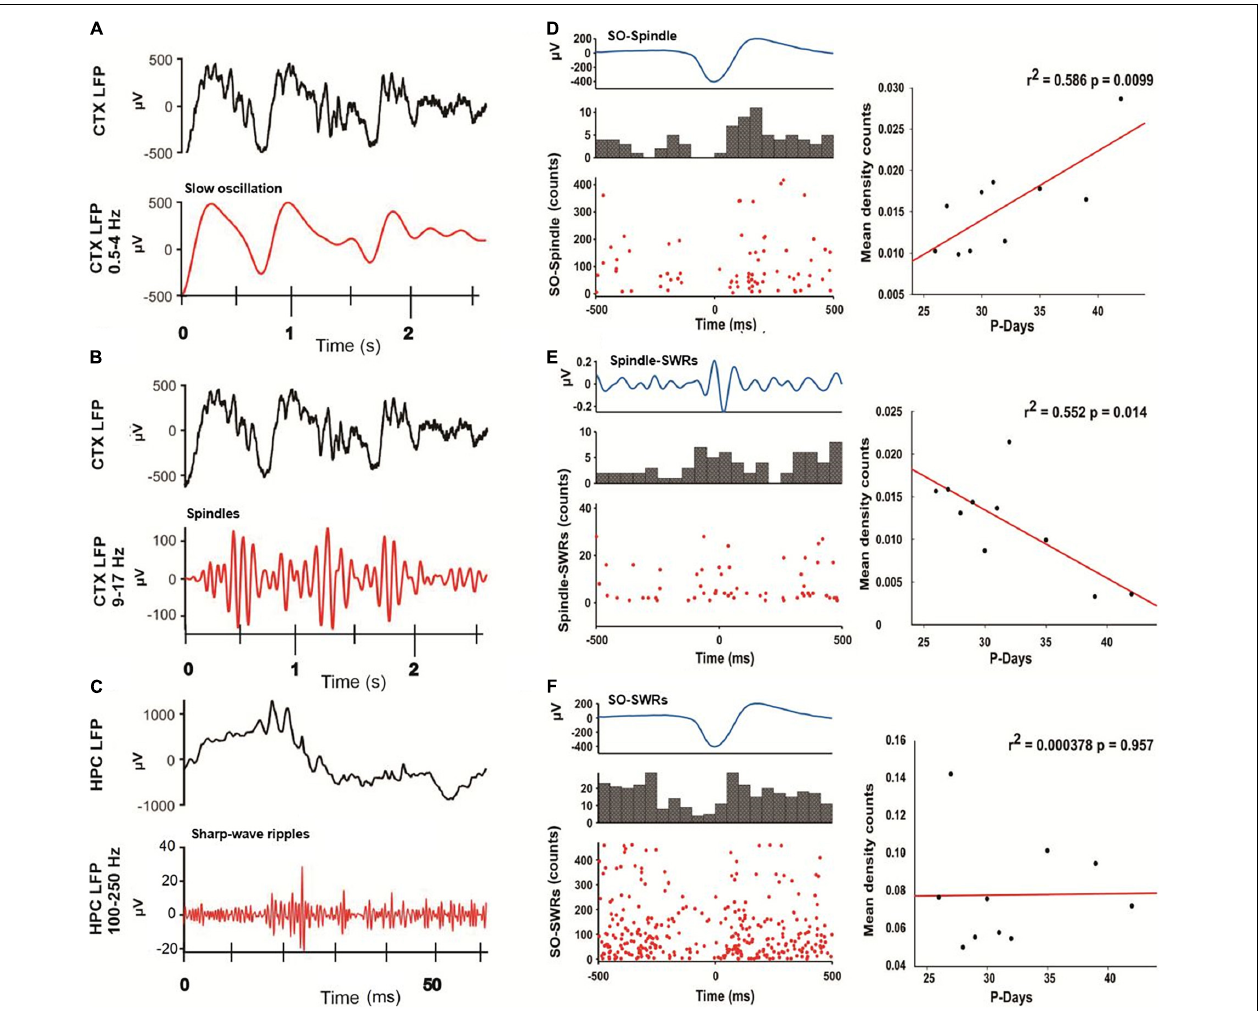
FIGURE 7 | Temporal coupling between sleep-oscillations across postnatal ages. On the left panel, representative examples of LFP signals obtained from the cortex (CTX) and hippocampus (HPC) are indicated to illustrate the three oscillations detected in this present work. (A) Raw CTX-LFP in black, and its respective filtered signal in red (0.5–4 Hz) for SO events detection. (B) Raw CTX-LFP in black and respective filtered signal (9–17 Hz) in red for Spindle events detection. (C) Raw HPC-LFP in black and respective filtered signal (100–250 Hz) in red for a detected SWR. (D) Representative example of SO-Spindle coupling. On top, SO grand average waveform across all postnatal days. The SO down-state was centered at 0 lag. In the middle, a cross-correlation histogram showing the number of counts of Spindles temporal coupling events related to the SO down-state ( ± 500 ms). A raster plot shows all the Spindle-SO counts in the lower panel. Linear regression (panel on the right) among the mean density (counts/min) with respect to postnatal days. There is a positive correlation between SO and Spindles coupled events across postnatal days ( n = 4; r 2 = 0.586 and p = 0.0099). (E) A representative example of Spindle-SWR cross-correlation analysis as described before on top Spindle grand average waveform (Spindle peak centered at 0 lag). In the middle, a cross-correlation histogram shows the number of SWR counts related to the Spindle’s peak ( ± 500 ms), and the lower panel is a raster plot showing all the sharp-wave ripples events coupled to the Spindle’s peak. On the right, a negative relationship between the temporal coupling of Spindles and SWR across days was found ( r 2 = 0.0552, p = 0.014). (F) The same analysis was conducted for SO and SWR coupling events across days. The linear regression (panel on the right) indicates no linear relationship between those oscillatory events over time ( r 2 = 0.000378, p =